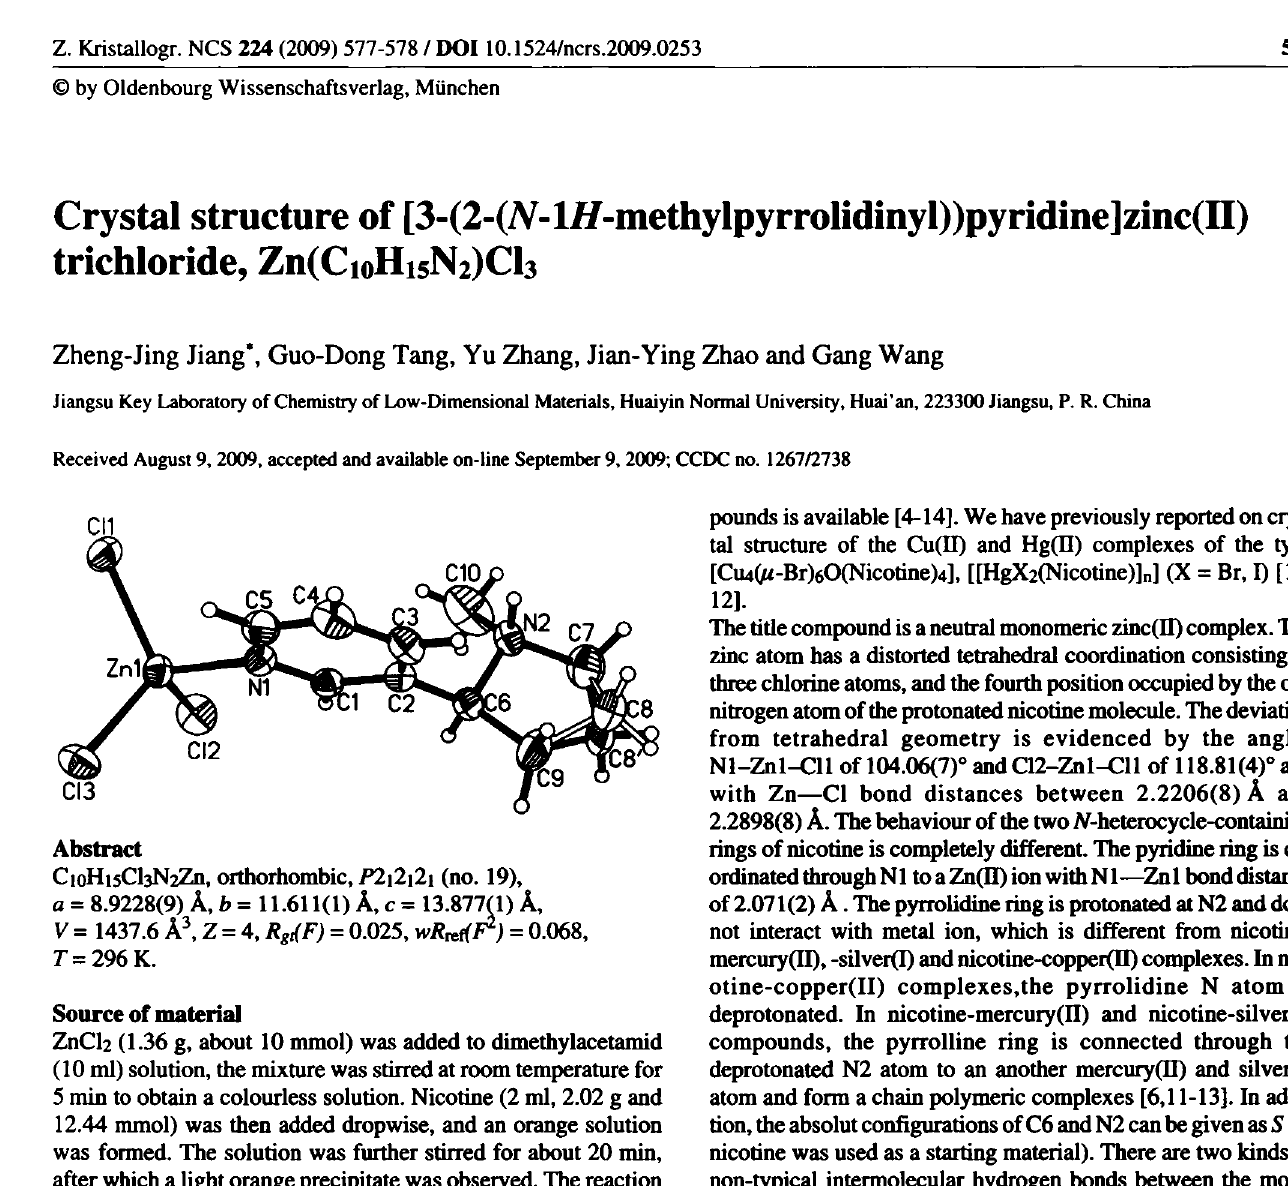
Table 1. Data collection and